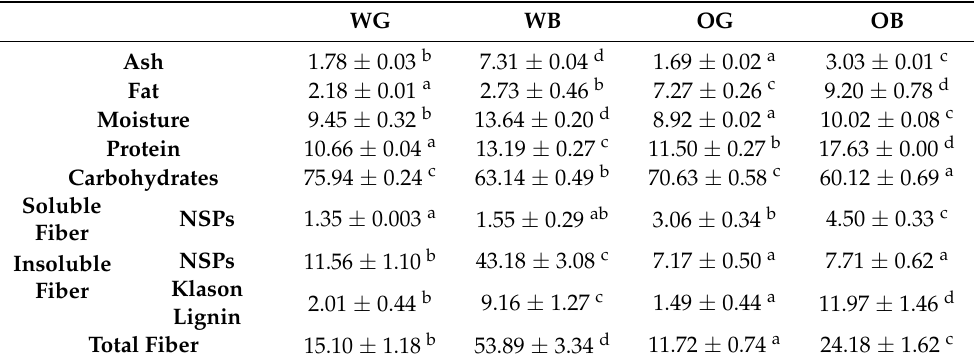
Table 1. Proximal composition of wheat grain (WG), wheat bran (WB), oat grain (OG), and oat bran (OB). Values were expressed as g 100 g − 1 of sample. NSPs (non-starchy polysaccharides), KL (Klason